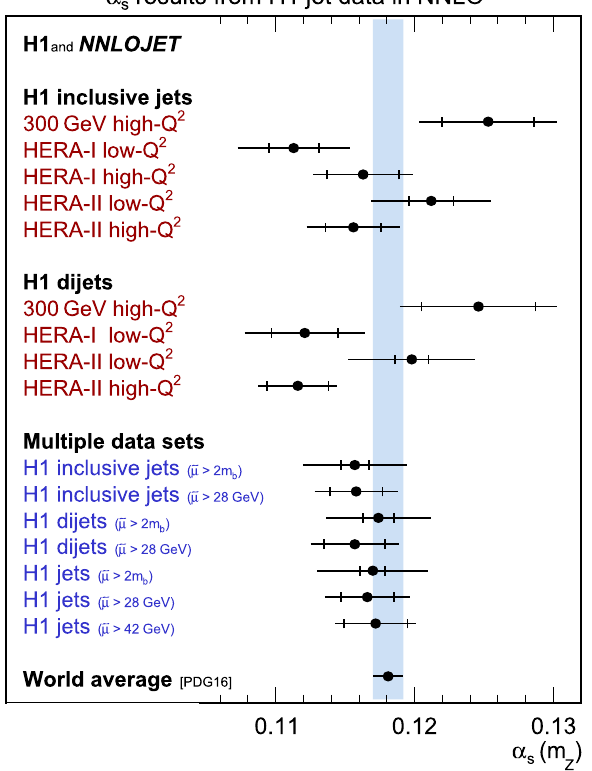
Fig. 11 Summaryof α s ( m Z ) valuesobtainedfromfitstoindividualand multiple H1 jet data sets. The inner error bars indicate the experimental uncertainty and the outer error bars the total